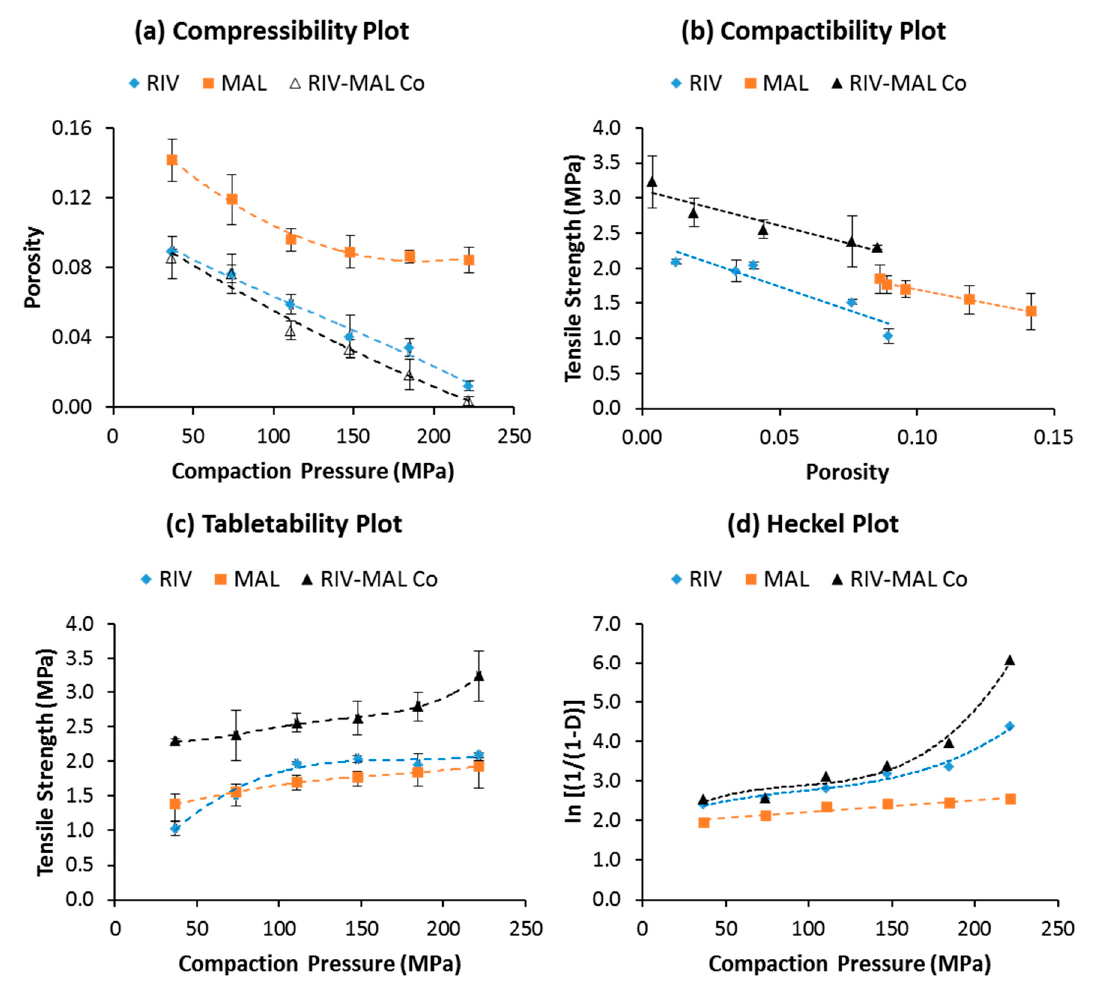
Figure 4. ( a )–( d ) Compressibility, tabletability, and compactibility, and Heckel plots for MAL, RIV, and RIV-MAL and RIV-MAL Co.